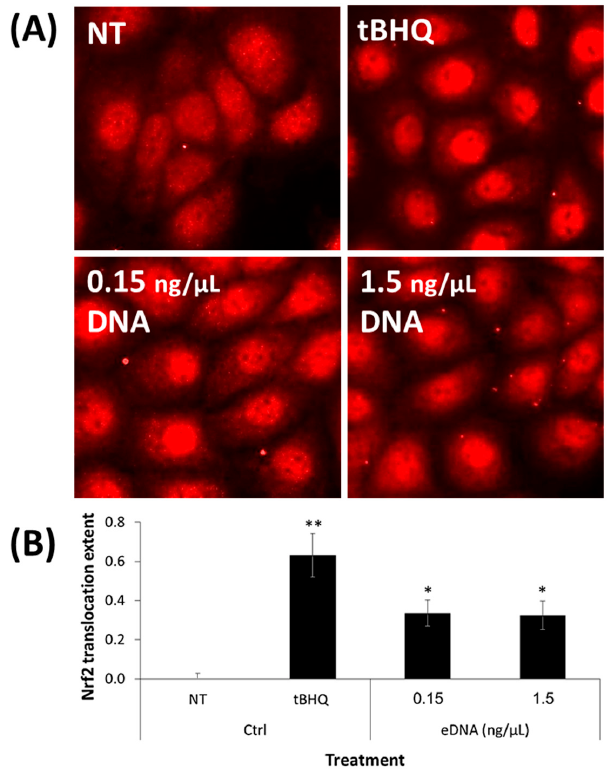
Figure 5. eDNA treatments induced Nrf2 nuclear translocation in HaCaT cells after a 6 h incubation. ( A ) Nuclear translocation of Nrf2 visualized using immunofluorescent staining (Alexa-fluor-647-labeled antibody, red) and imaging (magnification: ×20); ( B ) fluorescent signal quantification using ImageJ software. Data are expressed as the difference in the nuclear-to-cytoplasm fluorescent signal ratio between the treated and nontreated cells ( Δ nuc/cyt ratio). * p < 0.05, ** p < 0.01 treated samples vs. NT.